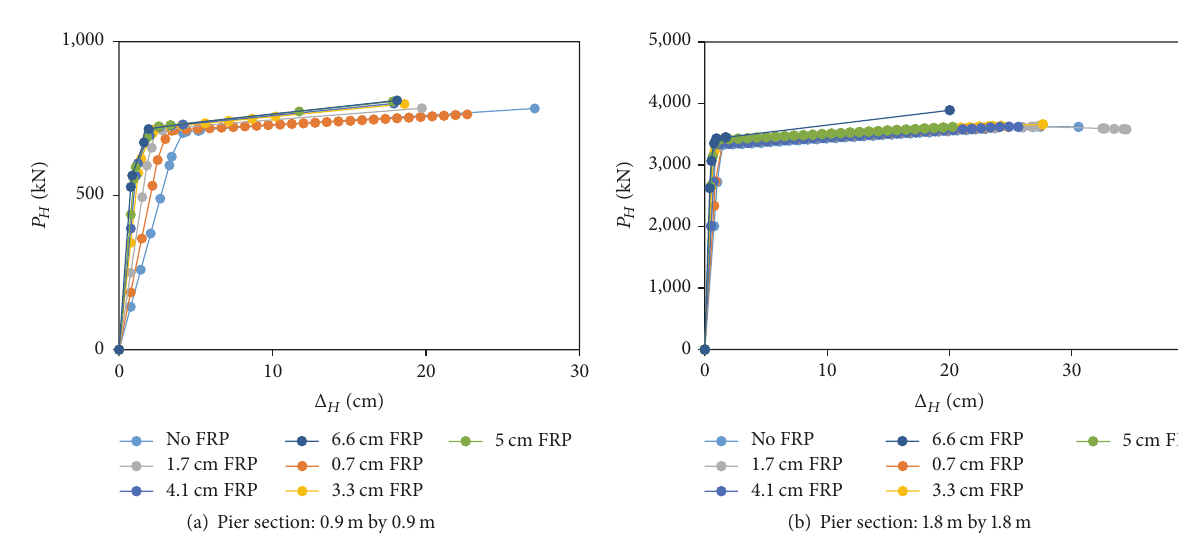
Figure 9: Slender pier system with 𝑊 = 6 m and 𝐻 = 12 m ( 𝑓 󸀠 𝑐 = 41